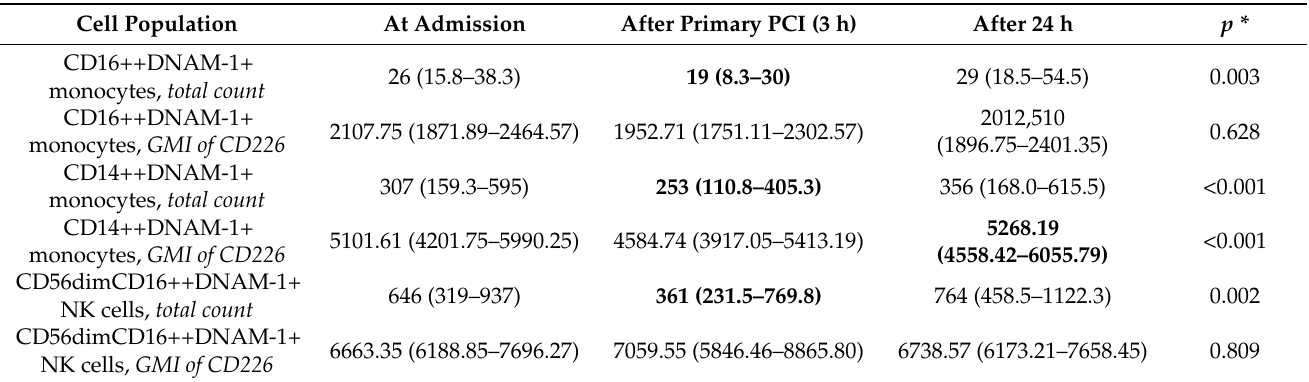
Table 2. Dynamics of DNAM-1+ subset of monocytes and NK cells after primary PCI in patients with STEMI.